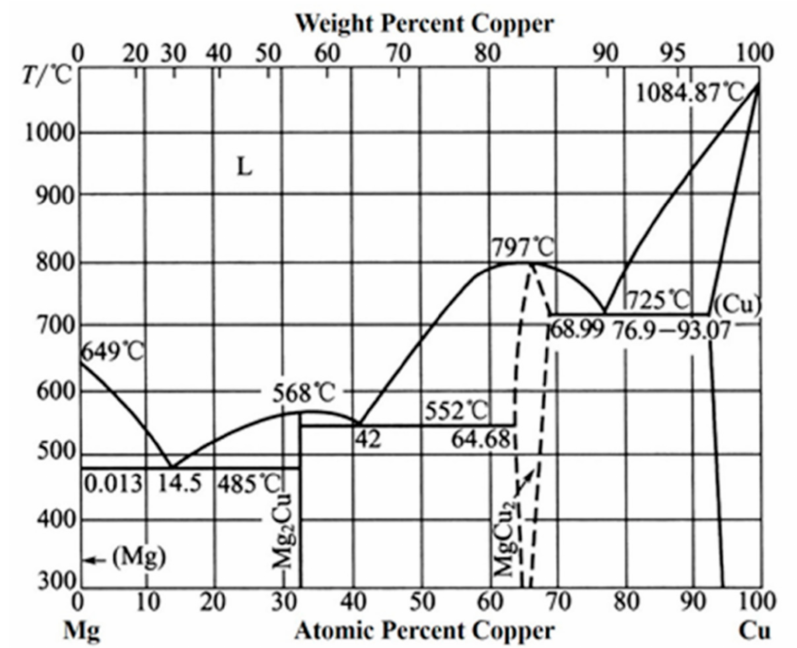
Figure 4. Mg-Cu binary phase diagram [20].